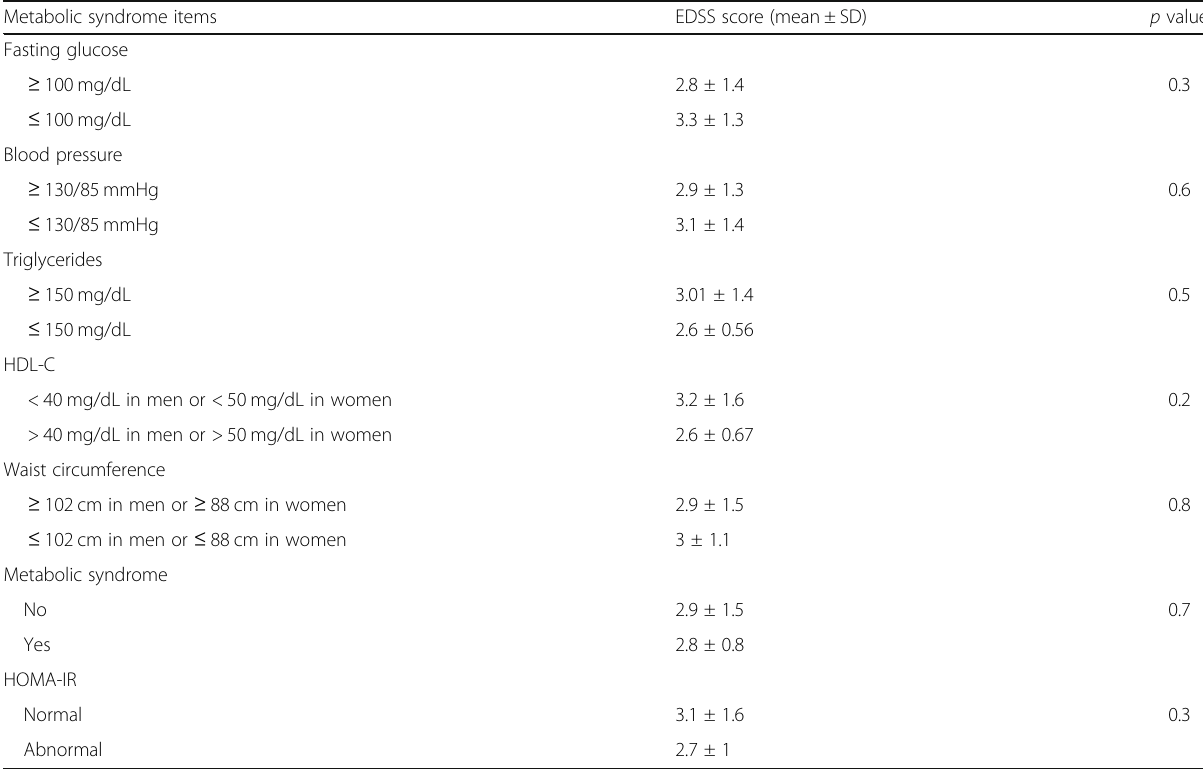
Table 4 Relation between metabolic syndrome components, HOMA-IR and EDSS scores among MS patients Metabolic syndrome